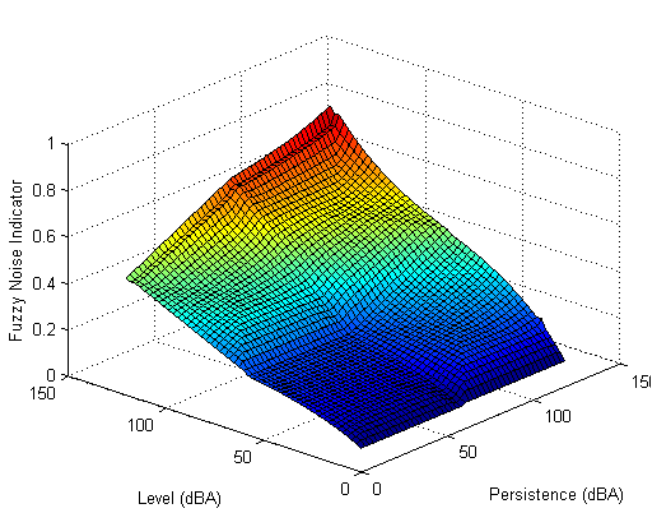
Figure 11. Input-output surface.